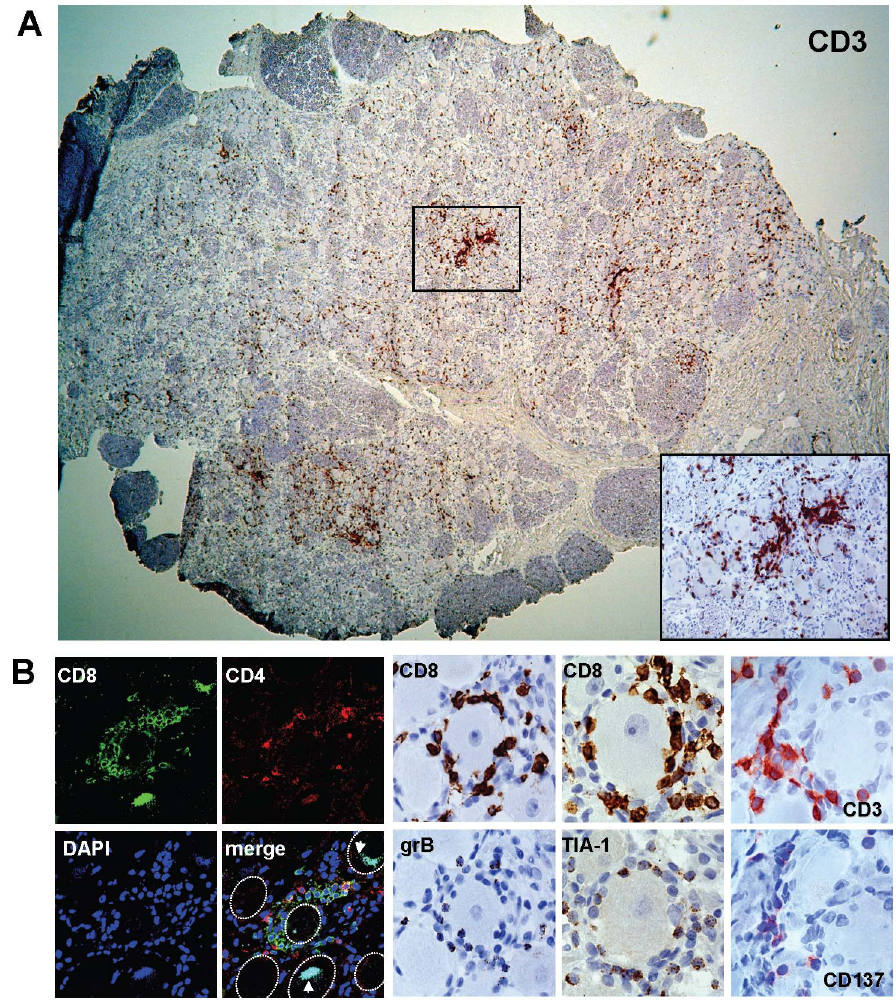
Figure 2. Localization and phenotype of T-cells in HSV-1 latently infected human TG. (A) Representative image of an HSV-1 latently infected TG stained by immunohistochemistry (IHC) for CD3 (red). Inset: magnification of the TG tissue showing a cluster of CD3 + cells in panel A. (B; left panel) Double immunofluoresence staining for CD4 (red) and CD8 (green) combined with DNA counterstaining (DAPI; blue nuclei). The white arrows signify autofluorescent cytoplasmatic granules in neurons containing lipofuscin and neuron outlines are marked with white dotted lines. (B; right panel) Consecutive TG tissue sections stained for CD8 (brown) and granzyme B (brown), CD8 (brown) and TIA-1 (brown), and CD3 (red) and CD137 (red). Sections were developed with diaminobenzidine (brown staining pattern) or 3-amino-9-ethylcarbazole (red staining pattern) and counterstained with hematoxylin (blue nuclei). Magnifications were: (A) 6 20 and inset 6 200, (B; left panel) 6 400 and (B; right panel) 6 1000. Representative images from 10 HSV-1 latently infected TG donors